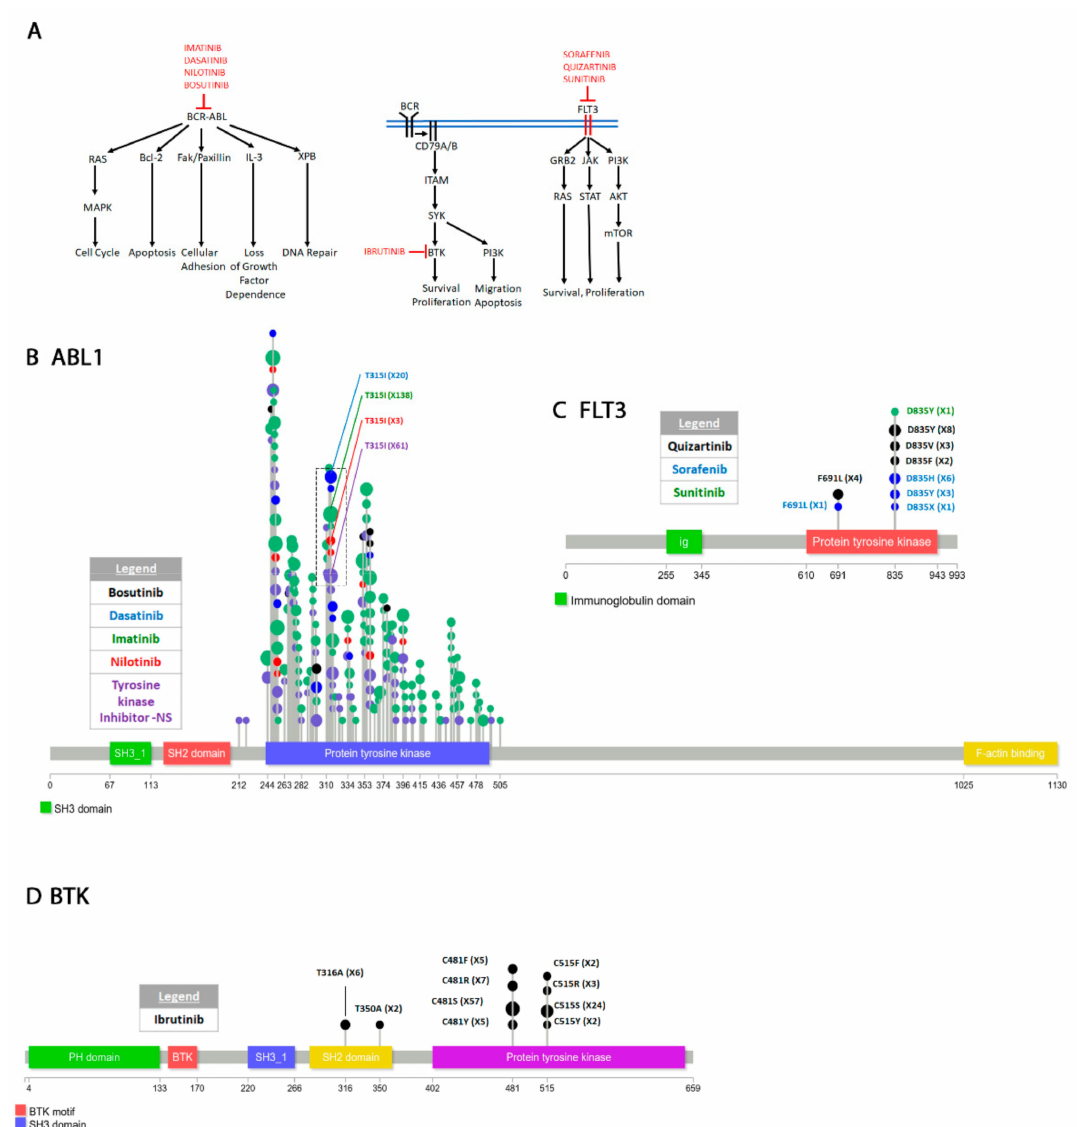
Figure 2. Pathways targeted in cancers of the hematopoietic and lymphoid tissue and drug resistant mutations. ( A ) The fused BCR-ABL protein signals through several pathways to activate cell cycle, apoptosis, adhesion, DNA repair and loss of growth factor dependence. The drugs that target the BCR-ABL fusion are shown. Some of these drugs also target the ABL1 wild type protein. Please see text for discussion. The pathways involving BTK and the FLT3 receptor tyrosine kinase are also shown because they are discussed in the text. ( B ) Mutations in the ABL1 gene cluster in the protein tyrosine domain. Only a few of the mutations are labeled to prevent clutter. Please see Supplementary Figure S1 for all mutations. ( C , D ) Resistant mutations in FLT3 and